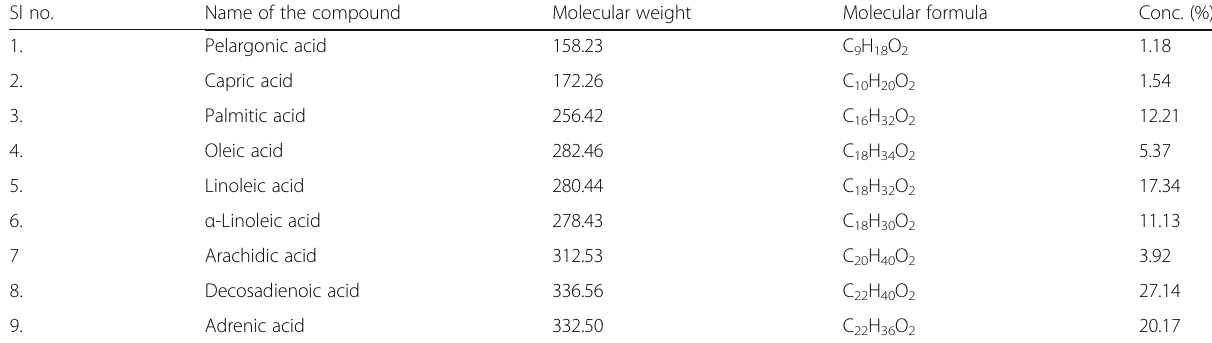
Table 4 GC-MS analysis of fatty acids of flowers of Cassia sophera Linn Sl no.